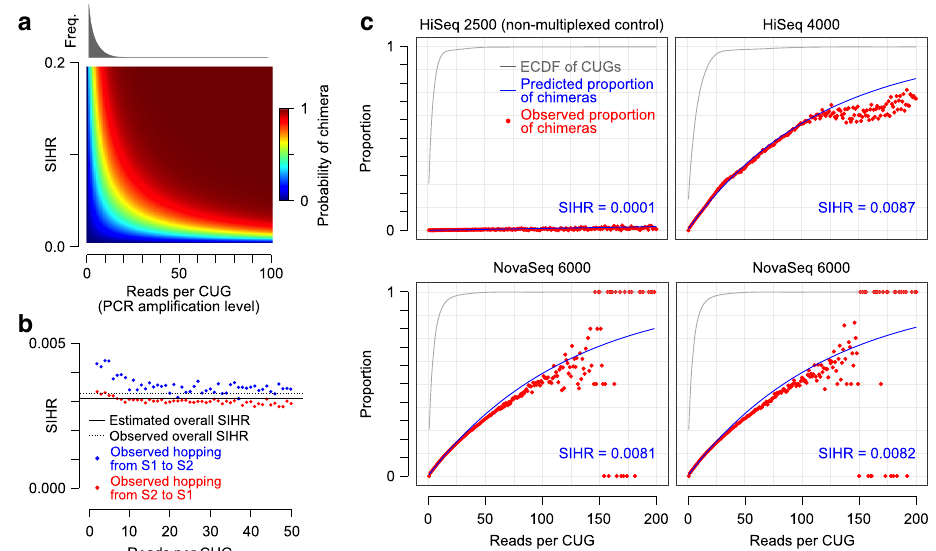
Fig. 2 Estimation of sample index-hopping rate. a A heatmap depicting the probability of observing a chimera, i.e., a CUG whose reads map to more than one sample, as a function of sample index-hopping rate (SIHR) and PCR ampli fi cation level r . See “ Methods ” for the probability function. The top histogram shows the distribution of r for an example multiplexed HiSeq 4000 dataset 6 . b Validation data showing the ground truth proportion of hopped reads by sample conditional on the PCR duplication level alongside the ground truth marginal mean proportion of hopped reads and the model-estimated sample index-hopping rate (same dataset as Fig. 1c, d). c Concordance between model predictions and empirically observed number of chimeras for four previously published datasets. Each plot shows the proportion (probability) of chimeras conditional on PCR ampli fi cation level, with red dots depicting observed values and blue line representing the model prediction. The ECDF (empirical cumulative distribution function) of r (gray) shows the cumulative proportion of CUGs with at most r reads. Top left: mouse epithelial non-multiplexed HiSeq 2500 dataset 7 ; top right: mouse epithelial multiplexed HiSeq 4000 dataset 6 . Bottom left: Tabula Muris NovaSeq 6000 dataset (Lane 1) 8 . Bottom right: Tabula Muris NovaSeq 6000 dataset (Lane 2) 8